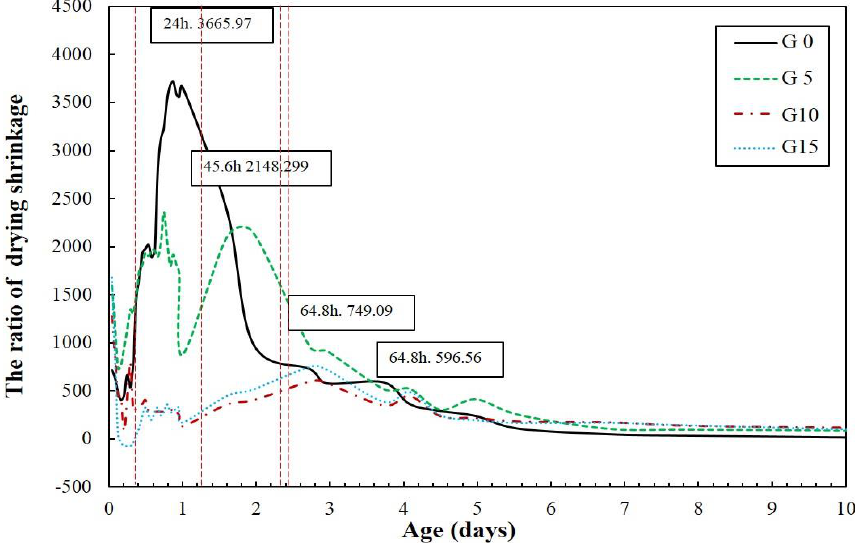
Figure 3. The ratio of drying shrinkage of the specimens.